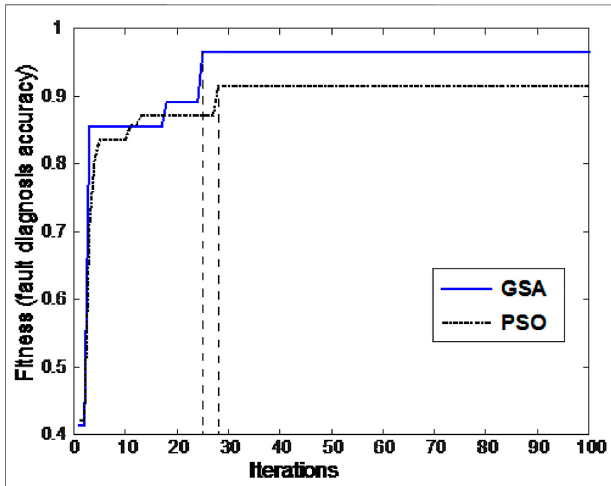
FIGURE 4 | Parameter tuning results for GSA and